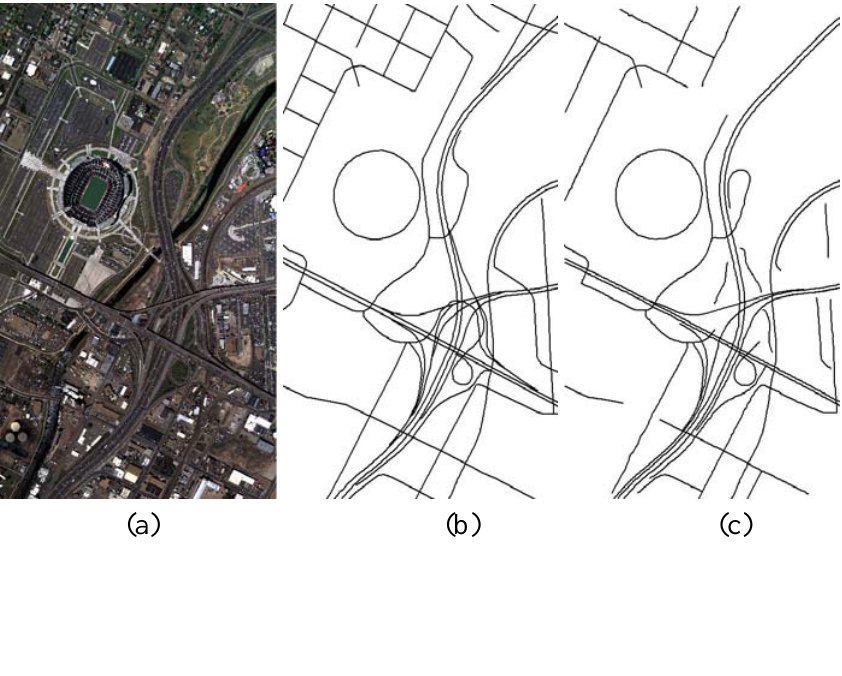
Figure 7. Road network extraction from a DMC airborne image. (a) DMC image with 0.2 m pixel -1 resolution and a 12,428 pixels by 7,780 pixels image size; (b) the reference road network plotted; (c) the extracted vector road network by combination